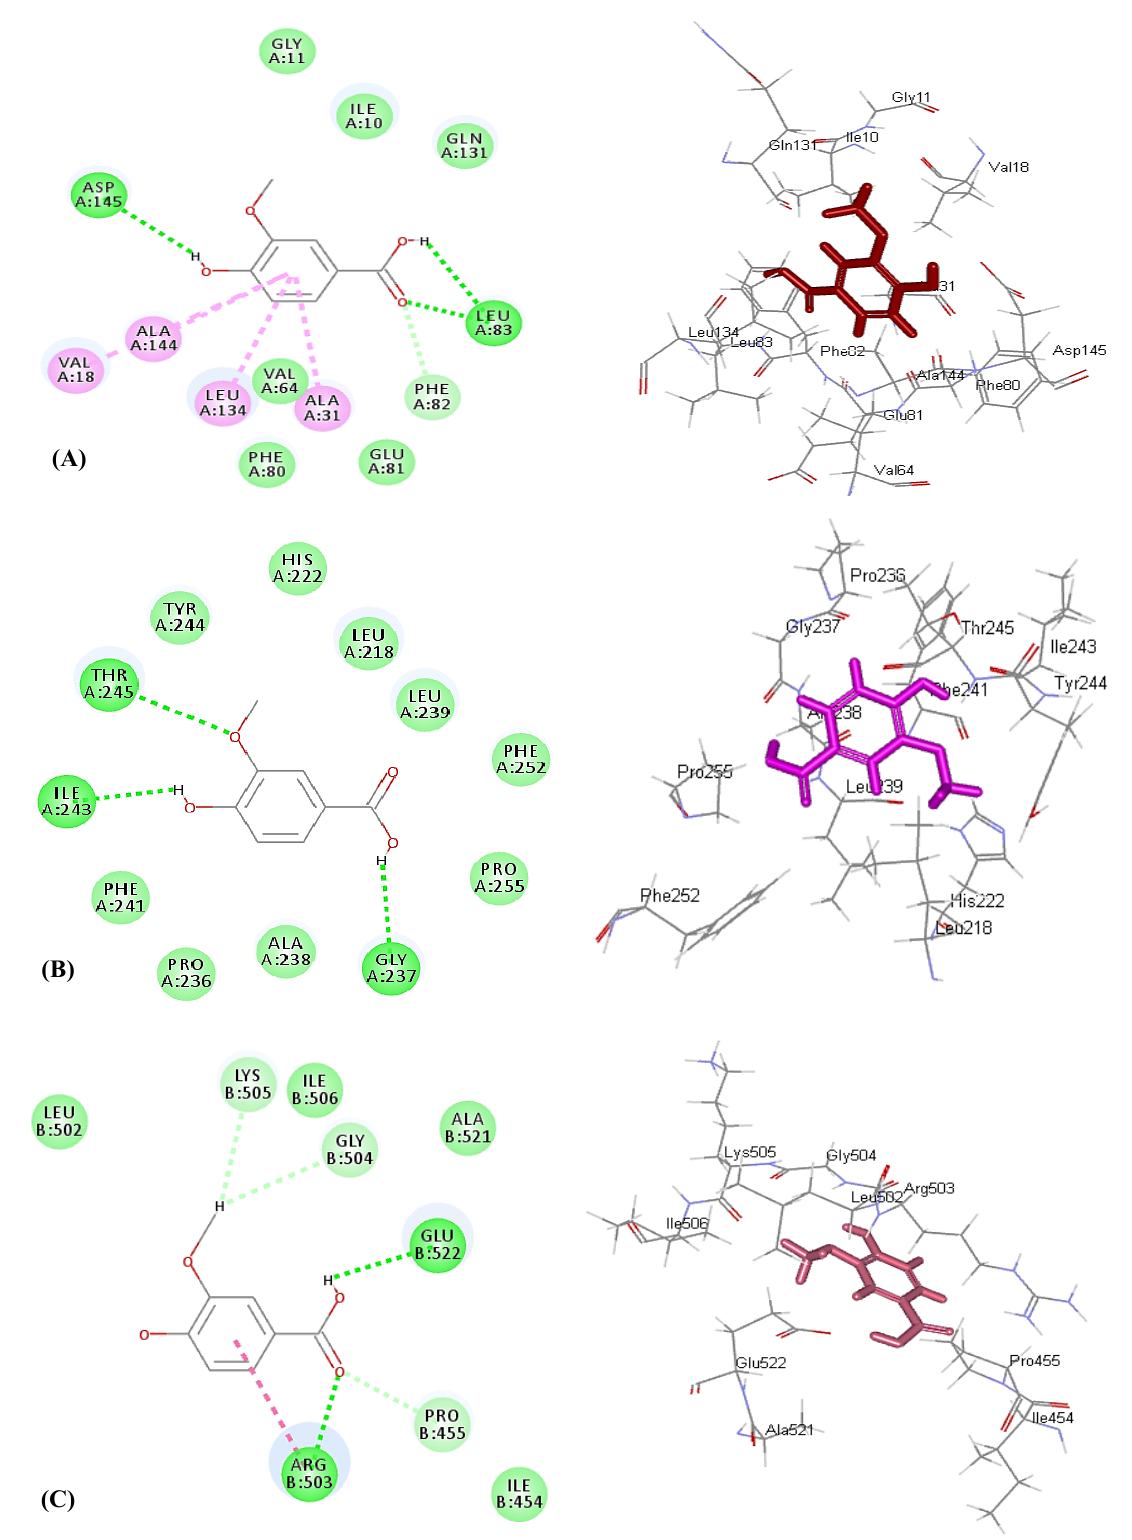
Figure 4. Two-dimensional and 3D binding mode of vanillic acid ( 2 ) within the active site of cyclin-dependent kinase 2 ( A ) , matrix metalloproteinase 13 ( B ), and DNA topoisomerase II ( C ) .